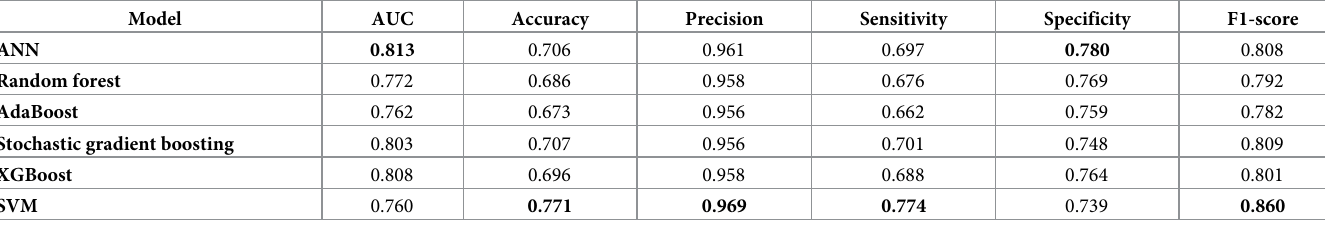
Table 3. Average metrics of six models trained with stepwise backward